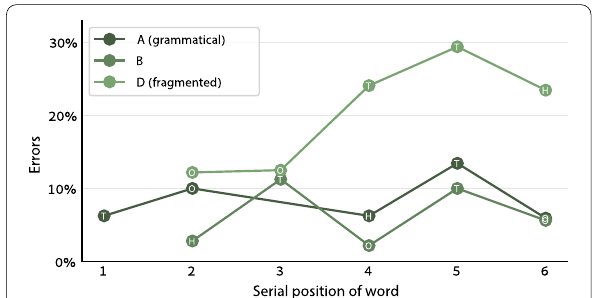
Fig. 3 Digit error rate in the 6-word numbers in Experiment 1 for each serial position of the number words. In condition D, the error rate was the lowest for the first two words and increased thereafter (except the last word)—a standard pattern of primacy effects in free recall tasks. Conditions A and B did not show this pattern: In these conditions, the error rate did not show a consistent pattern. The word “thousand” is not plotted here, as its digit error rate is undefined. The letters H, T, and O denote a Hundreds, Tens, and Ones